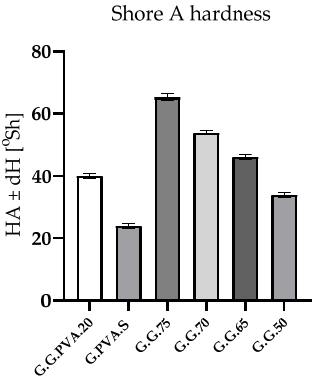
Figure 3. Hardness measurements of gelatin composites.